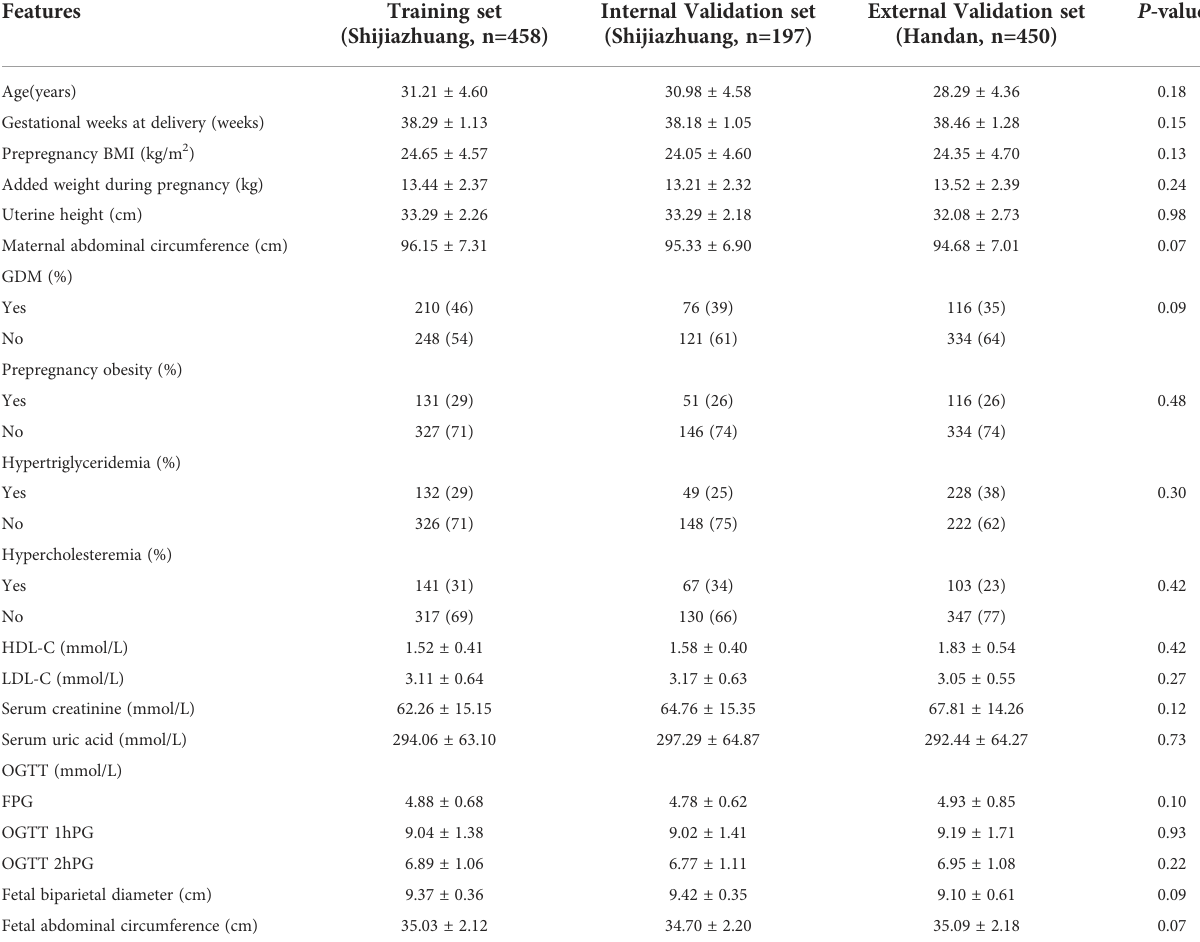
TABLE 1 Characteristics of the population in training set and validation